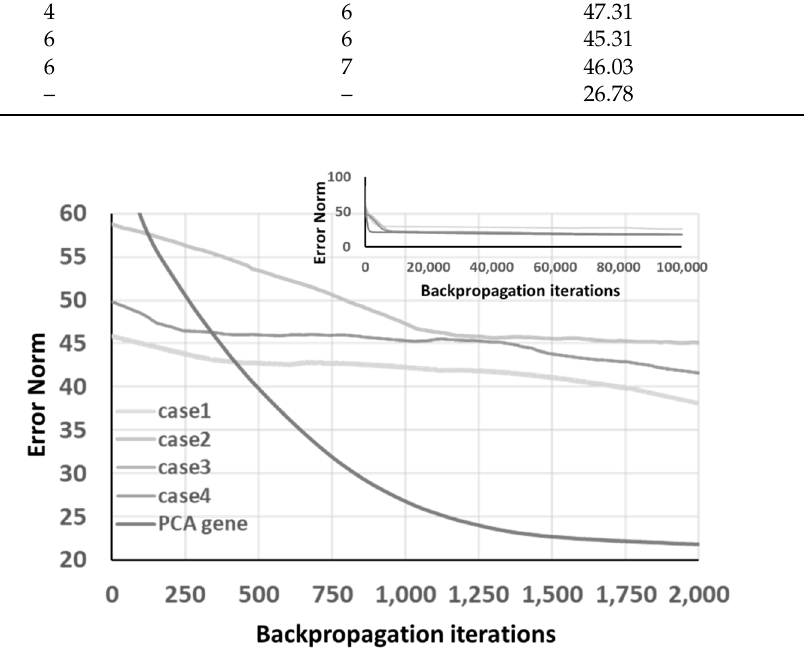
Figure 19. The convergence of 4 GA “progressing” optimized chromosomes and PCA gene under RNN architecture. Table 8. The RNN training result under GA “progressing” optimizer by the same initial 2000 GA generation in Table 5.